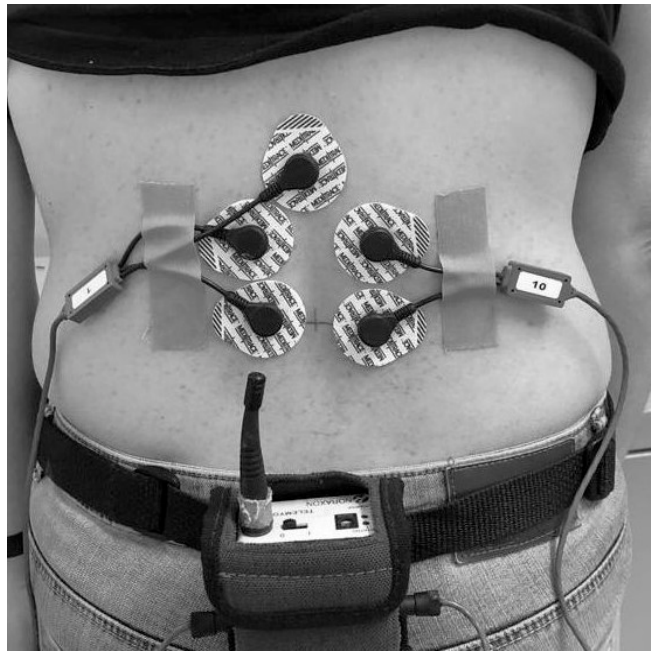
Figure 1. Electrodes placement.